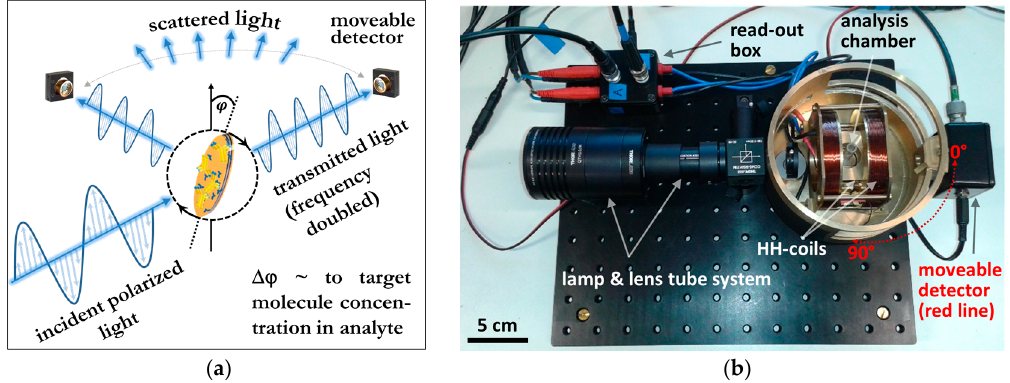
Figure 1. ( a ) Detection principle: The nanoprobe follows a rotating magnetic field with phase lag ϕ , which changes upon molecular binding; ( b ) MLoB-setup suitable for all-angle